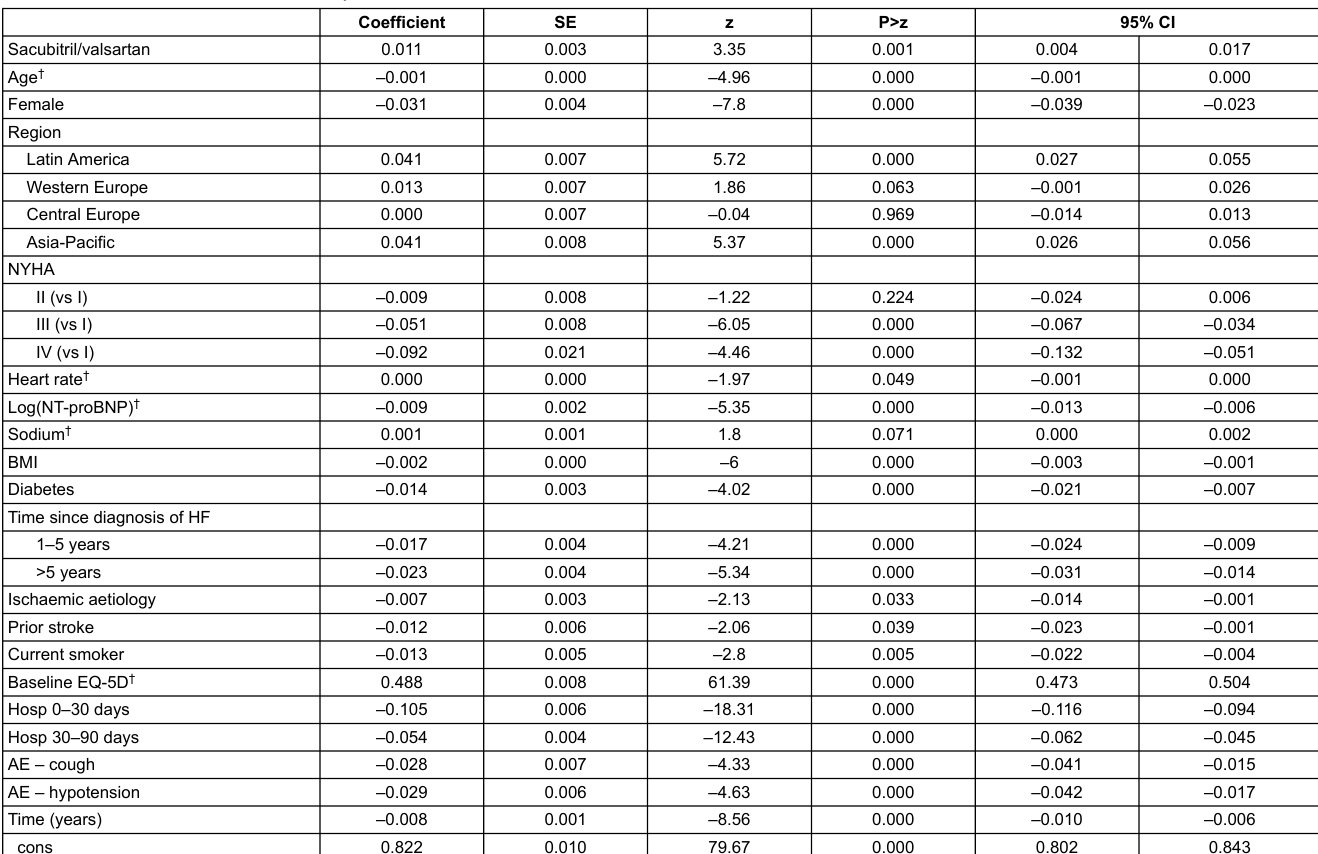
Table S9: Mixed model for EQ-5D-based utility